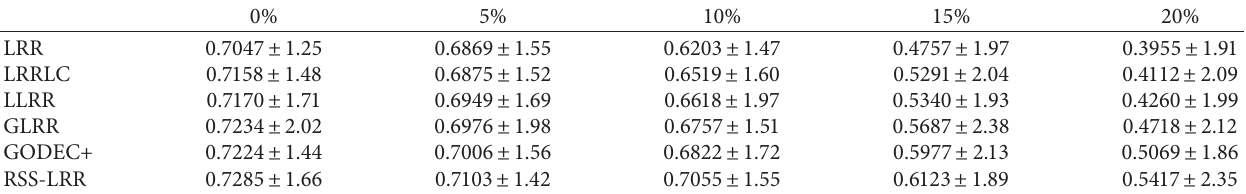
Table 4: Clustering results concerning the accuracy of different algorithms on the COIL20